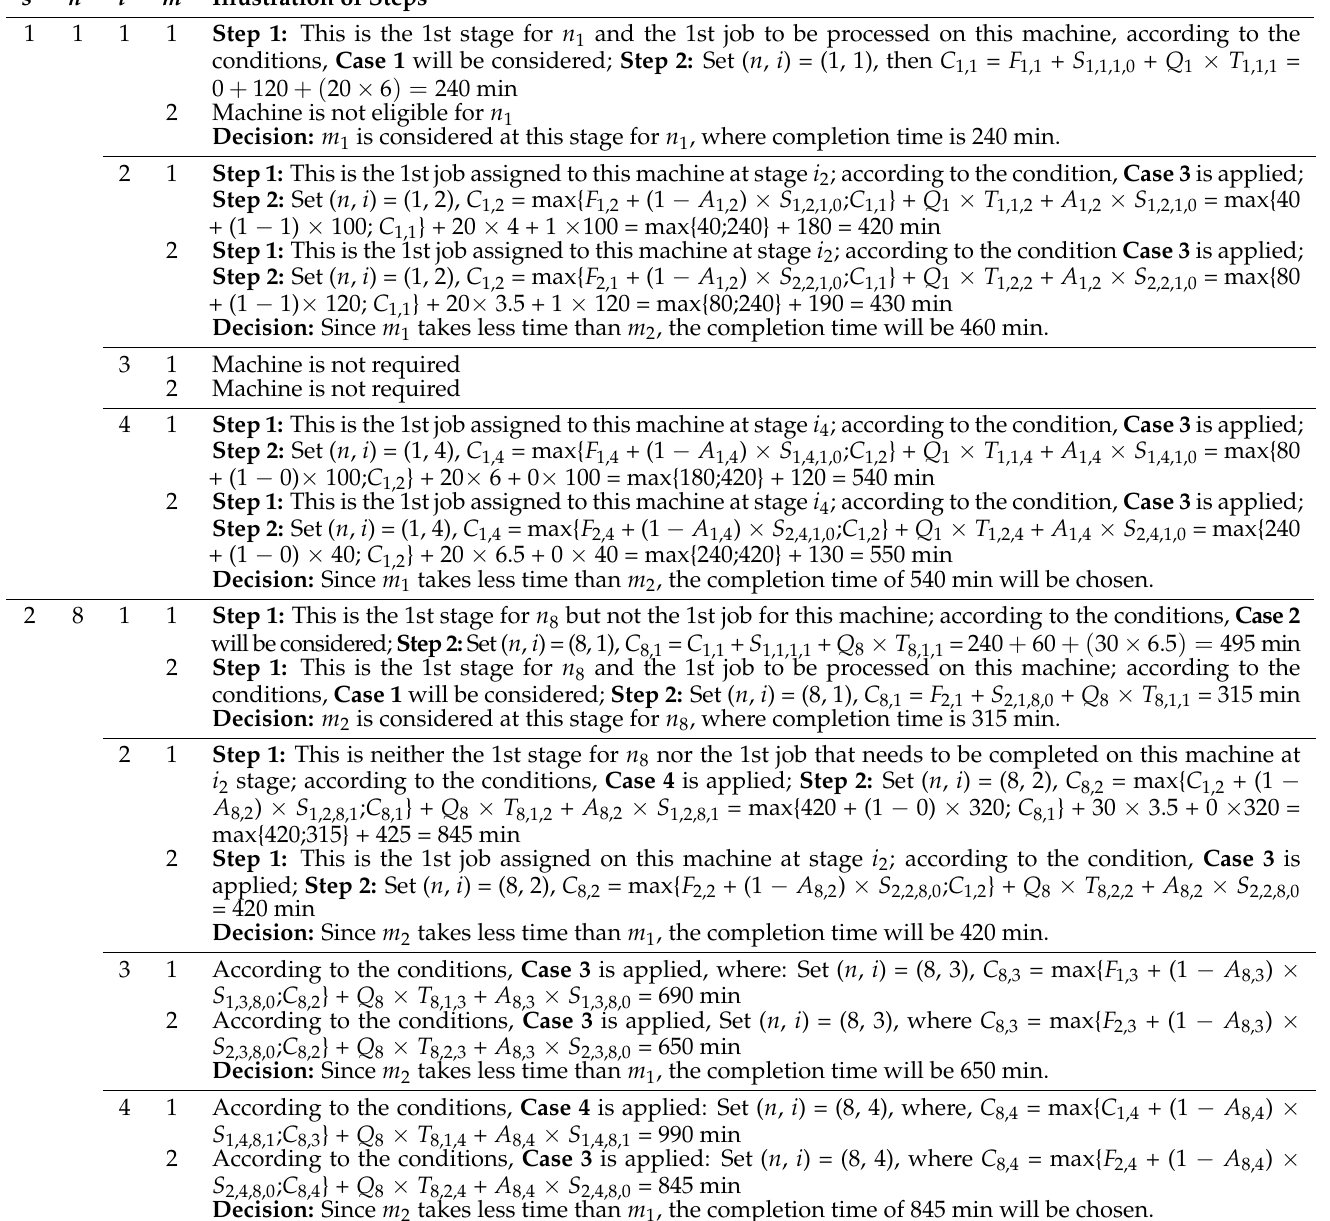
Table 6. A partial decoding steps of GA for the solution representation in Figure 9. This decoding process will continue until all the jobs are assigned at each